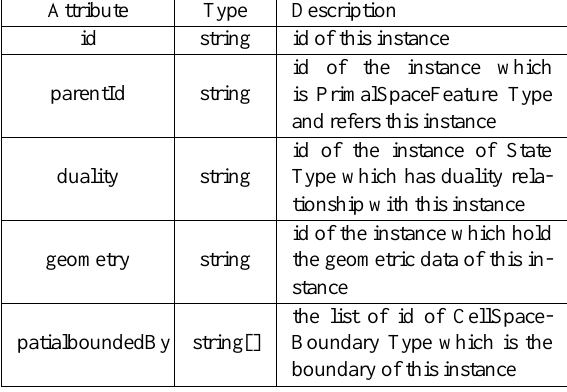
Table 3. The main attributes in the Java class of CellSpace